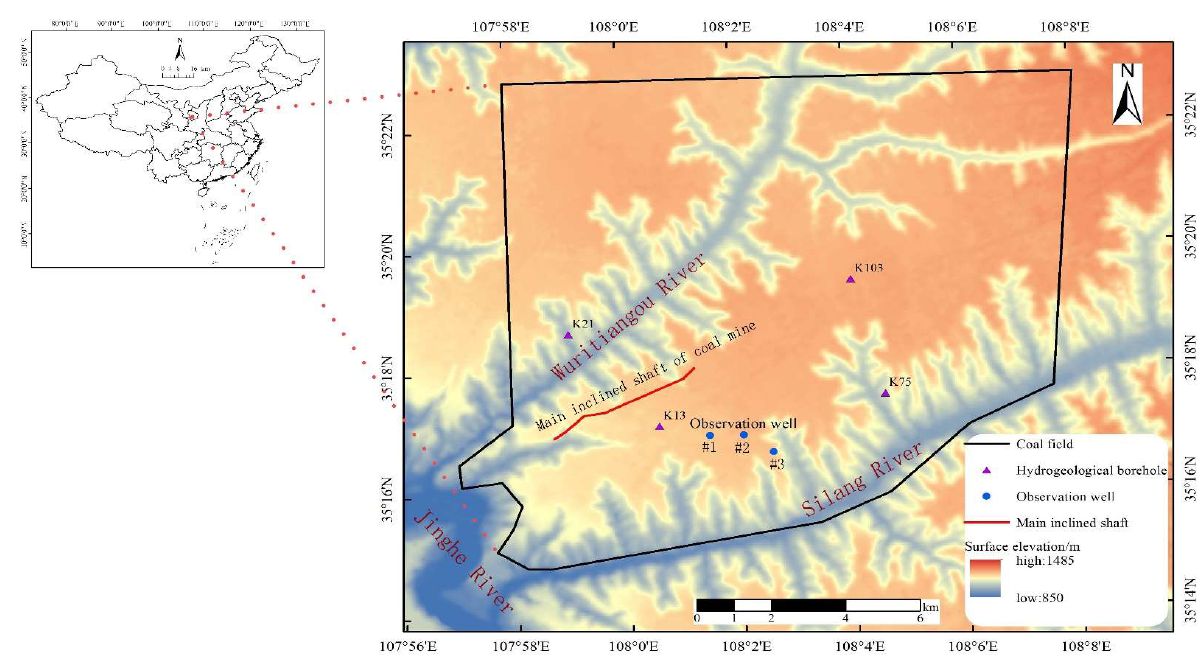
Figure 1. The location of the Hetaoyu coal